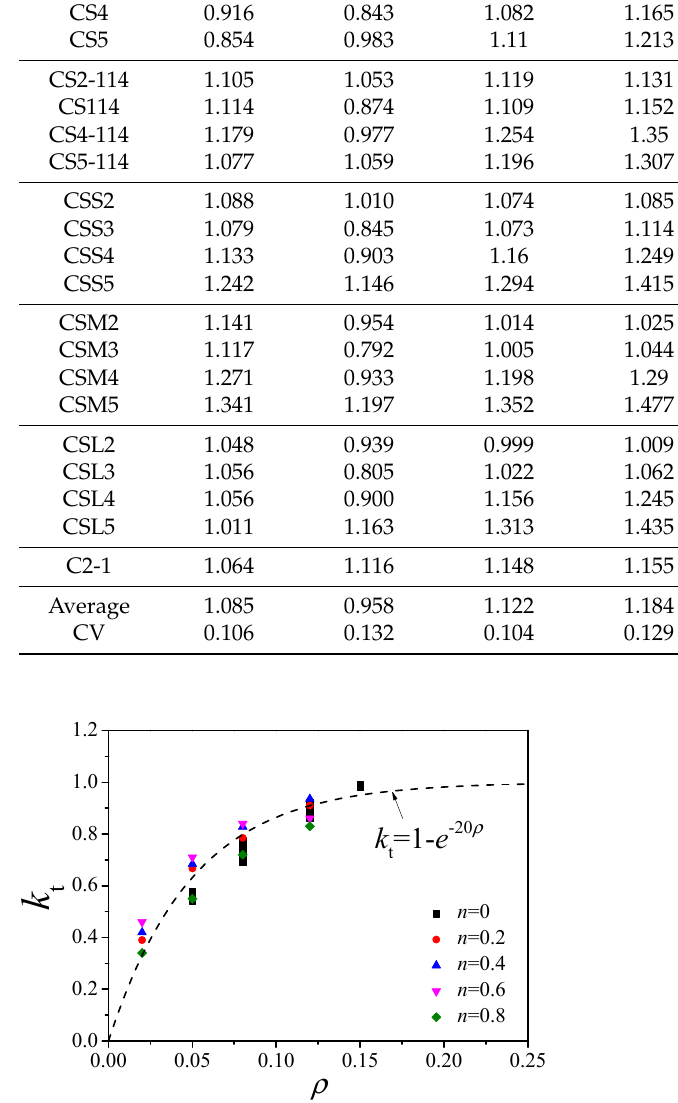
Figure 17. k t – ρ correlation curve of the compression-torsion columns.